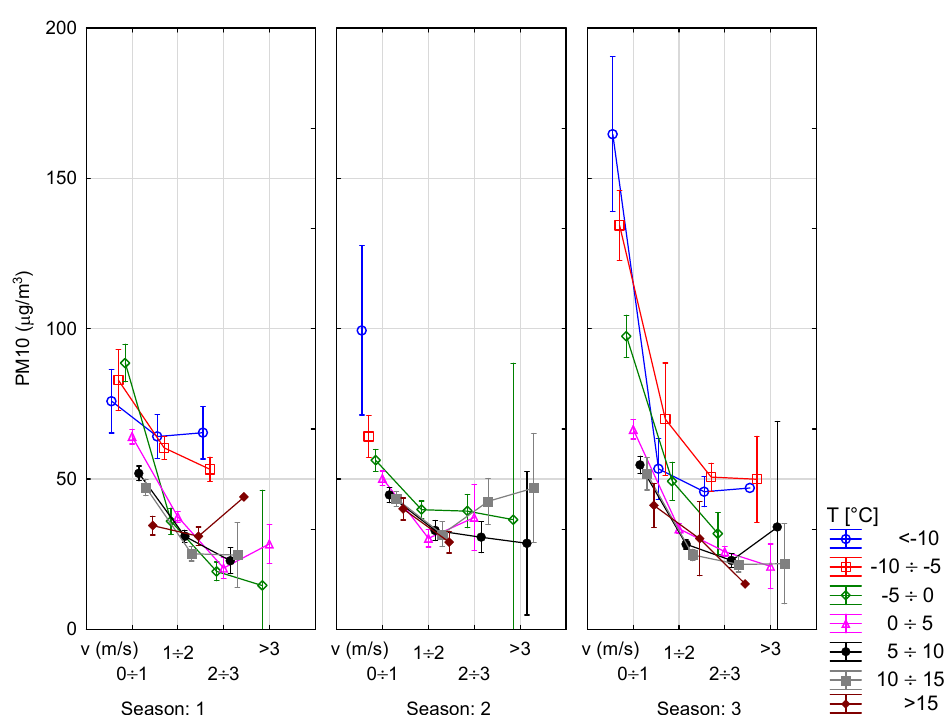
Figure 9. Relation between SO 2 concentration, temperature and wind speed.